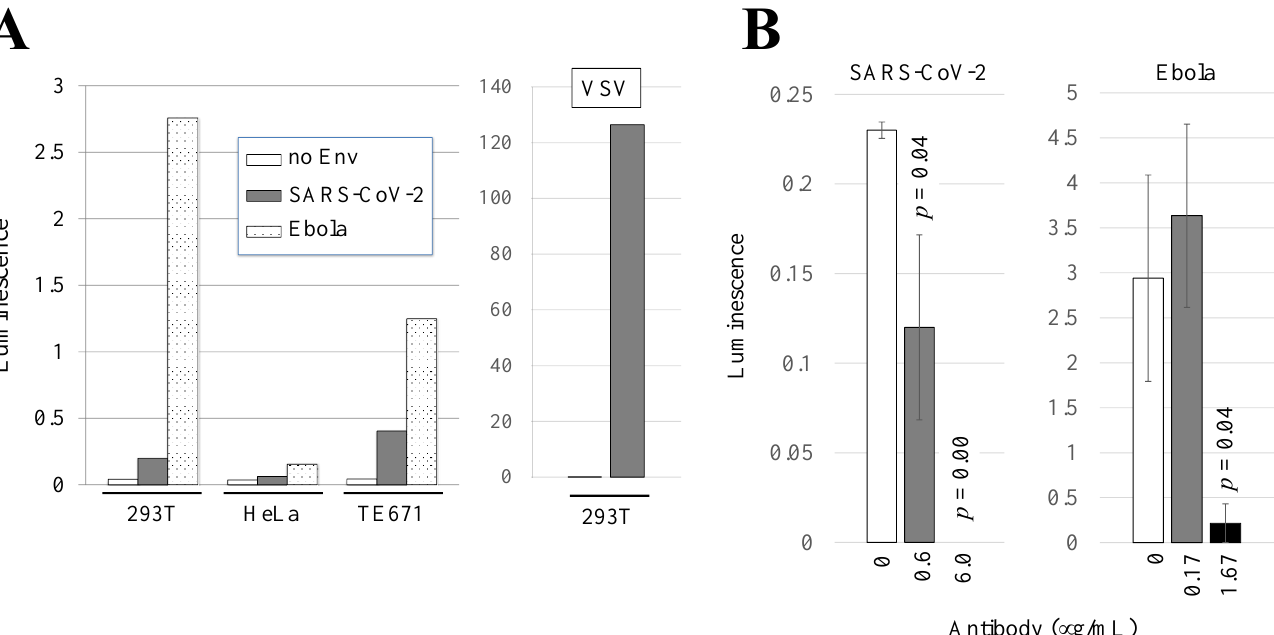
Figure 1. Susceptibility of 293T, HeLa, and TE671 cells to Ebola virus- or SARS-CoV-2-pseudotyped HIV-1 vector infection. ( A ) Human 293T, HeLa, and TE671 cells were inoculated with HIV-1 vector containing Ebola virus or SARS-CoV-2 envelope glycoprotein. The vector encodes the luciferase gene, and luciferase activities of the inoculated cells were measured. This experiment was repeated three times. Representative luminescence values are indicated. ( B ) Target 293T cells were inoculated with indicated pseudotyped HIV-1 vector in the presence of an antibody. Luminescences in inoculated cells were adjusted by the subtraction of those with HIV-1 vector without any viral envelope proteins. The subtracted values are indicated. This experiment was performed in triplicate. Error bars indicate SDs. When the differences compared to control cells are significant, the p values of Student’s t -test are indicated.